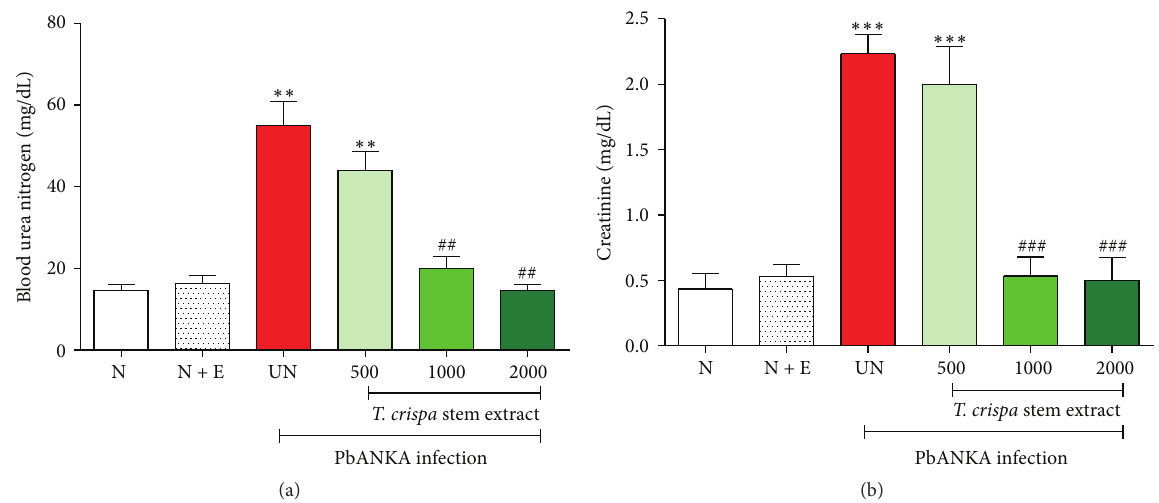
Figure 2: Protective effect of Tinospora crispa stem extract on renal damage induced by Plasmodium berghei infection. ICR mice (5 mice of each) were inoculated with 1 × 10 7 parasitized erythrocytes of PbANKA by intraperitoneal injection. The extracts (500, 1000, and 2000 mg/kg) were given orally by gavage for 4 consecutive days. On day 4 of experiment, (a) BUN and (b) creatinine levels were then measured. Results were expressed as mean ± SEM. ∗∗ 𝑃 < 0.01 and ∗∗∗ 𝑃 < 0.001, compared to normal control, and ## 𝑃 < 0.001 and ### 𝑃 < 0.001, compared to untreated control. N: normal control, N + E: normal mice treated with 2000 mg/kg of extract, and UN: untreated control. The results came from 3 independent experiments.